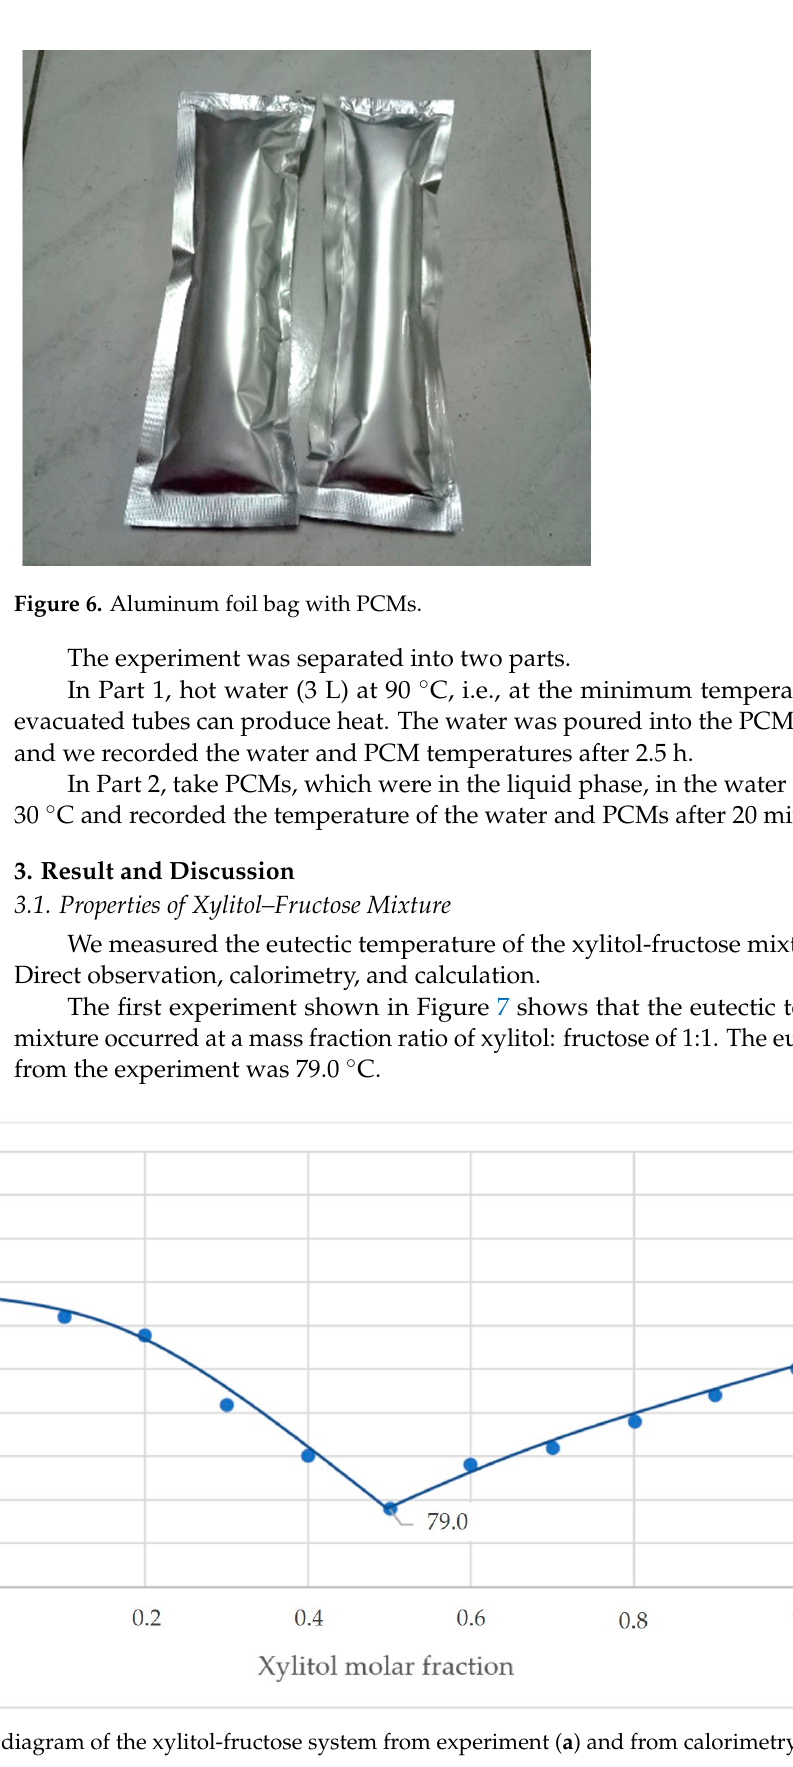
Figure 7. Phase diagram of the xylitol ‐ fructose system from experiment ( a ) and from calorimetry ( b ).